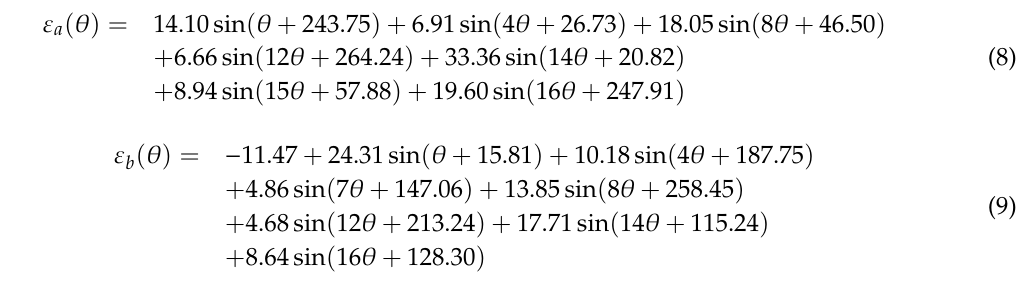
Figure 9. Sensors 2020 , 20 , x FOR PEER REVIEW